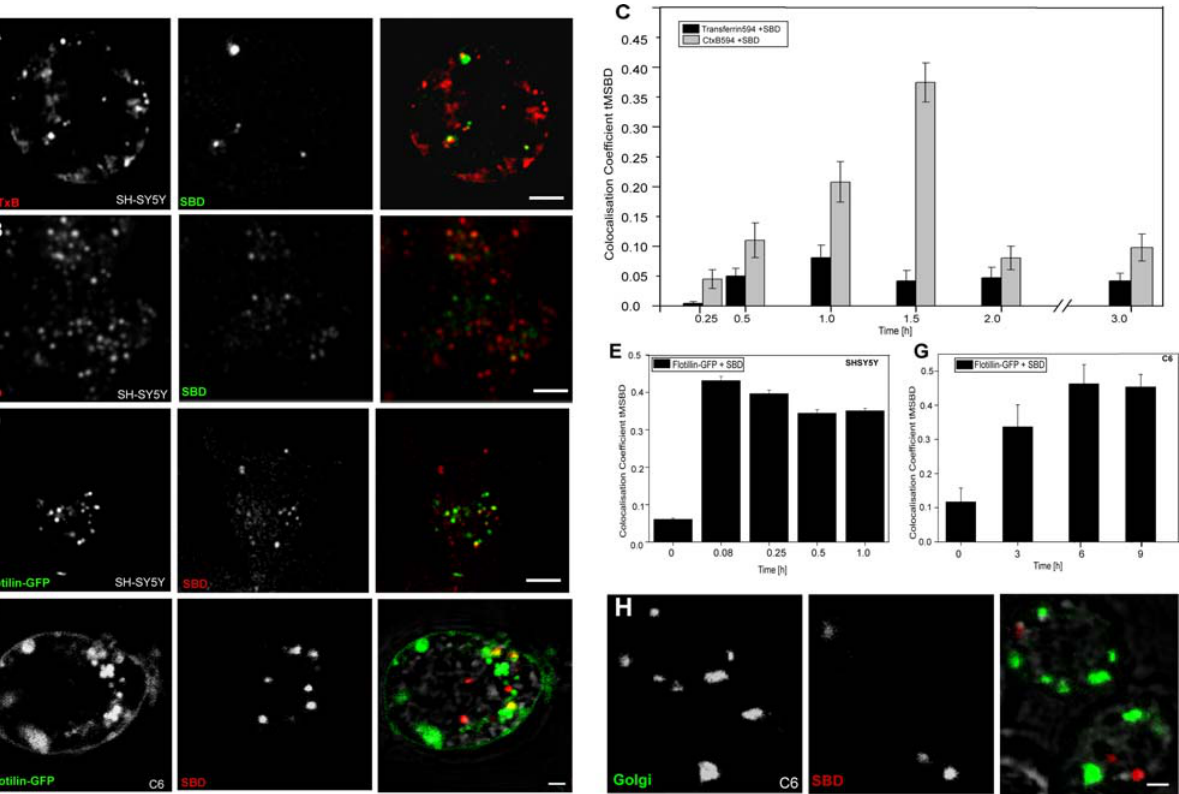
Figure 5. SBD trafficking converges to differing extents over time with lipid raft markers CtxB and Flotillin-GFP, but not with clathrin-uptake marker Transferrin or Golgi. A. Colocalization of CtxB and SBD in SH-SY5Y neuroblastomas. CtxB-Alexa546 (red) was incubated for 30 min in growth medium at 37 u C, washed, then cross-linked with anti-CtxB (Vybrant, Invitrogen) for 15 min in growth medium at 37 u C, and washed. SBD-OG (green) was incubated immediately thereafter at 5 m M in growth medium for 10 min at 37 u C. Both labels were chased in phenol- red-free growth medium and imaged at the time-points given in graph (C). B. SBD does not colocalize with Transferrin (Tfn)-Alexa594, a marker of clathrin-mediated uptake, in SH-SY5Y neuroblastomas. Cells were labelled with Tfn-Alexa594 (10 m g/ml) for 30 min at 37 u C, washed, and incubated with SBD-OG (5 m M) for 10 min at 37 u C, both in growth medium. Scale bar=5 m m for A, B, D. C. Colocalization time-course of SBD-OG with CtxB (gray bars) and Tfn-Alexa594 (black bars) in SH-SY5Y neuroblastomas. D. Flotillin2-GFP expressing SH-SY5Y neuroblastomas (green) were labeled 24h after transfection with SBD-TMR as in (A). E. Quantification of Flotillin2-GFP vs. SBD-TMR in SH-SY5Y. F. Flotillin2-GFP expressing c6 cells (green) were labeled 24h after transfection with SBD-TMR (10 m M) in growth medium for 15 min at 25 u C. SBD-TMR (red) uptake vesicles are distinct from Flotillin2- GFP vesicles in c6 cells, but increase in colocalization over time (graph in G). Cells were imaged between 60–90 min after application of labels in A–F. Scale bar=2 m m. G. Quantification of Flotillin2-GFP vs. SBD-TMR in c6 cells. H. SBD shows virtually no accumulation in the Golgi body in c6 cells. C6 cells were labelled as above with SBD-TMR, chased, fixed, and stained with an anti-Drosophila Golgi antibody (Merck). Scale bar=2 m m.